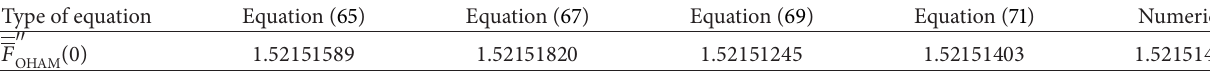
󸀠󸀠 (0) obtained by means of OHAM and numerical results for 𝛽 = 1.6 .